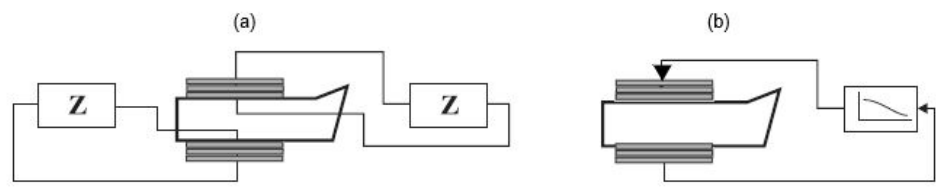
Figure 2. Multilayer piezoelectric layers: (a) passive strategy and (b) active strategy, adapted from (12).